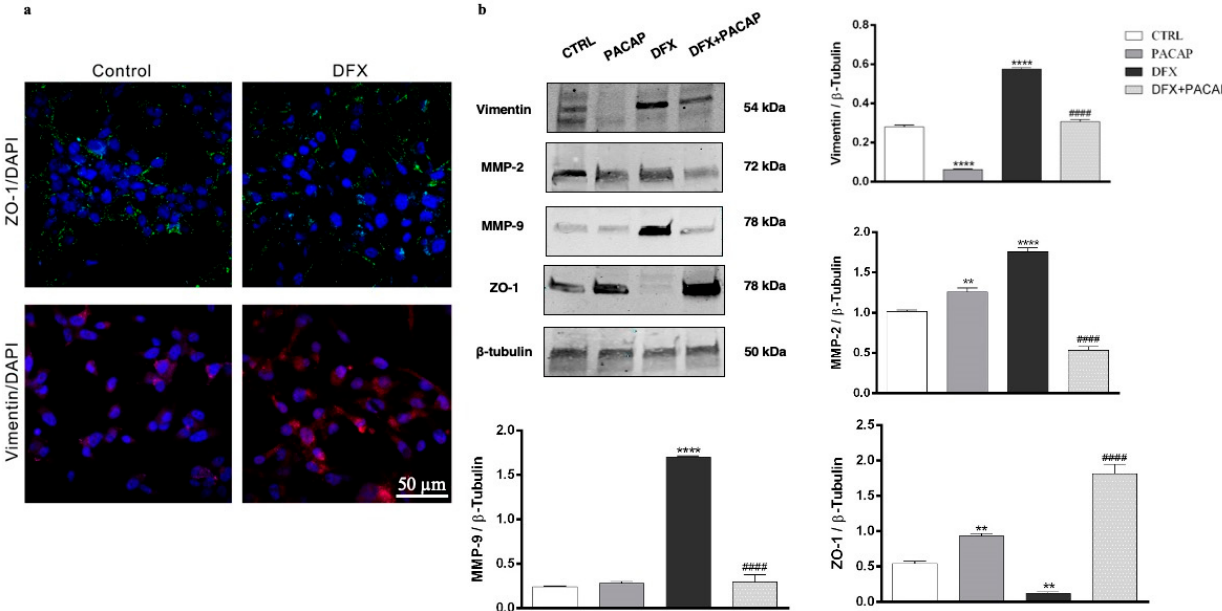
Figure 6. PACAP effect on EMT markers in human GBM cells exposed to DFX-induced hypoxia. ( a ) Immunosignal of ZO-1 (green) and Vimentin (red) expression in U87MG cells cultured in normal oxygen tension levels (control) or in hypoxic condition (DFX) for 24 h. The ZO-1 and Vimentin signals were detected using specific primary antibodies revealed with the Alexa Fluor 488 secondary antibodies (green fluorescence), and Alexa Fluor 594 secondary antibodies (red fluorescence), respectively. Cell nuclei were stained with diamidino-2-phenylindole, DAPI (blue fluorescence). The photomicrographs are representative results taken from different fields in randomly selected slides and scanned by confocal laser scanning microscopy (CLSM). Scale bar (50 μ m). ( b ) Representative immunoblots of Vimentin, MMP-2, MMP-9 and ZO-1 protein expression on U87MG cells cultured with PACAP or DFX or DFX plus PACAP or vehicle for 24 h. The bar graphs show quantitative analysis of signals obtained by immunoblots resulting from three independent experiments. Relative band densities were quantified by using ImageJ software. Protein levels are expressed as arbitrary units obtained after normalization to β -tubulin, which was used as loading control. Data represent means ± SEM. ** p < 0.01 and **** p < 0.0001 vs. CTRL; #### p < 0.0001 vs. DFX.